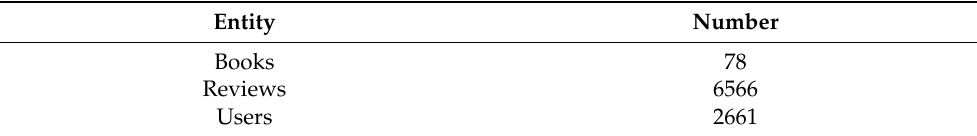
Table 1. Statistics of dataset collected from Goodreads